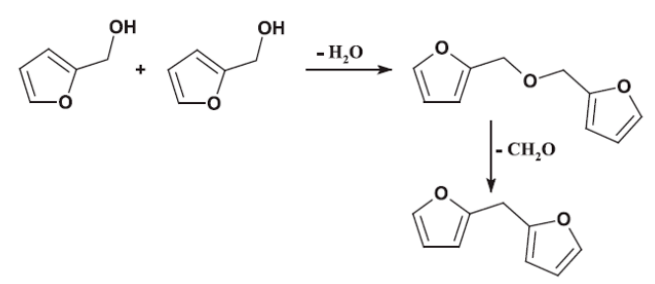
Figure 10. One of furfuryl polycondensation pathways: the reaction between the methylol groups of two furfuryl alcohol molecules, leading to dimethyl ether bridge that can be transformed into a methylene bridge by the release of formaldehyde [48].